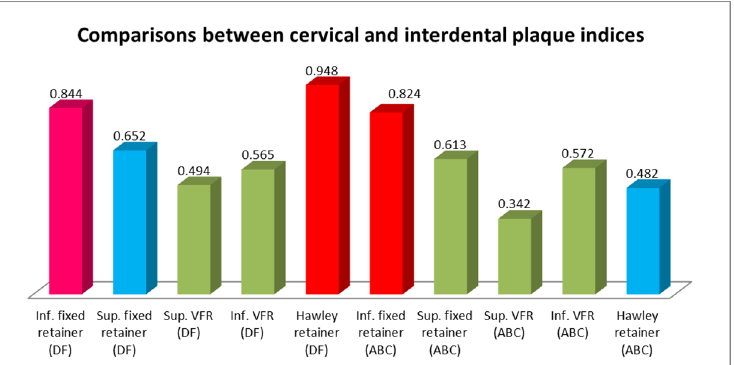
Figure 5. Navy plaque index modified by Rustogi, male study group. DF = interproximal areas ABC = gumline areas.